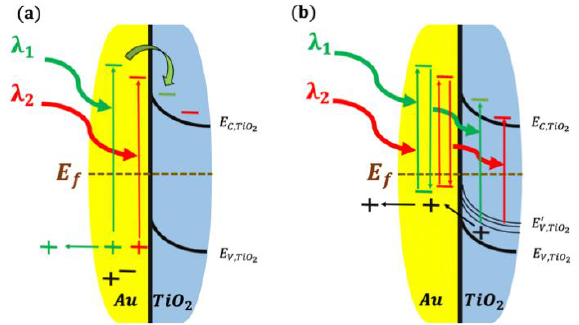
Figure 2. Au/TiO 2 interface band diagram: ( a ) direct electron transfer; and ( b ) plasmonic resonance electron transfer. Adapted from [60]. with permission from Springer Nature, 2016.